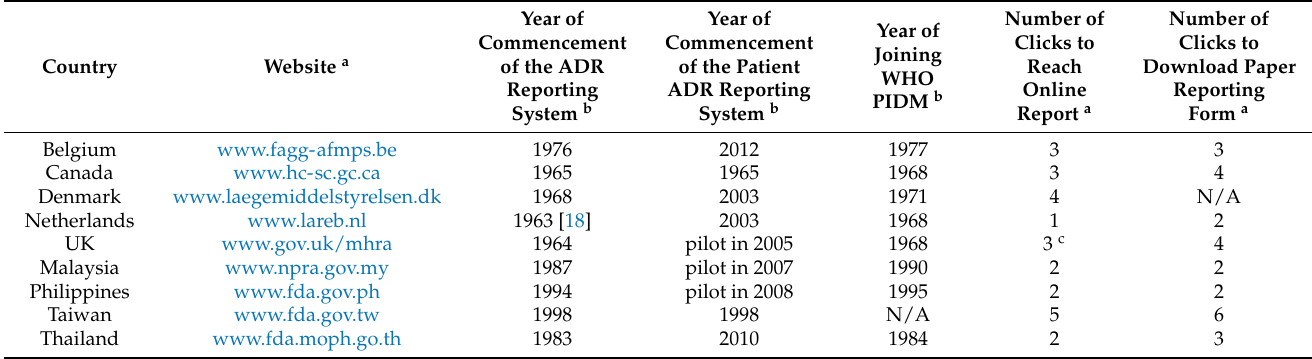
Table 2. Characteristics of the spontaneous report systems and patient reporting